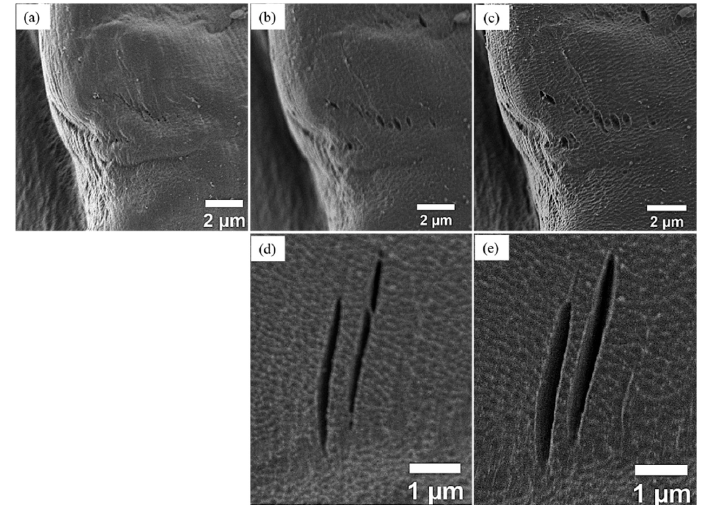
Figure 5. LV-SEM images of ramie fibers show the influence of plasma treatment on the pre-existing holes and cracks on the fiber surface, ( a ) untreated, ( b , d ) 2 min, ( c , e ) 3